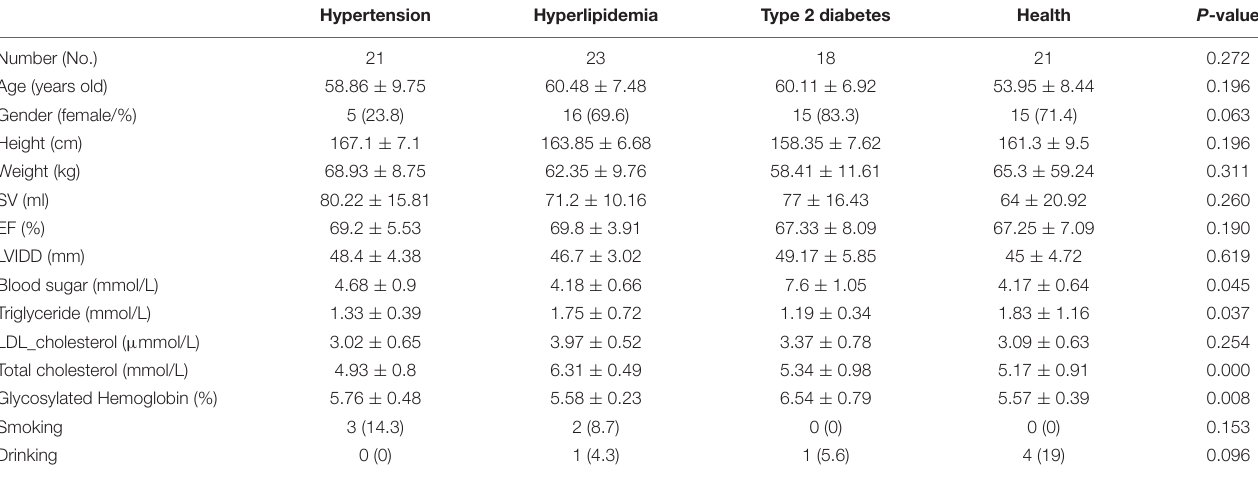
TABLE 1 | Base characteristics, clinic information and risk factors of study population. Hypertension Hyperlipidemia Type 2 diabetes